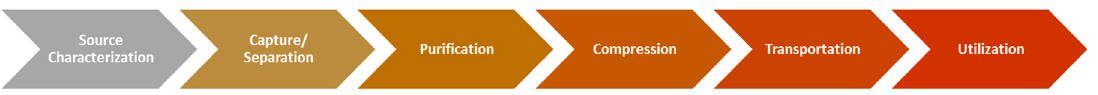
Figure 1. The six steps of a carbon capture and utilization (CCU) value chain.